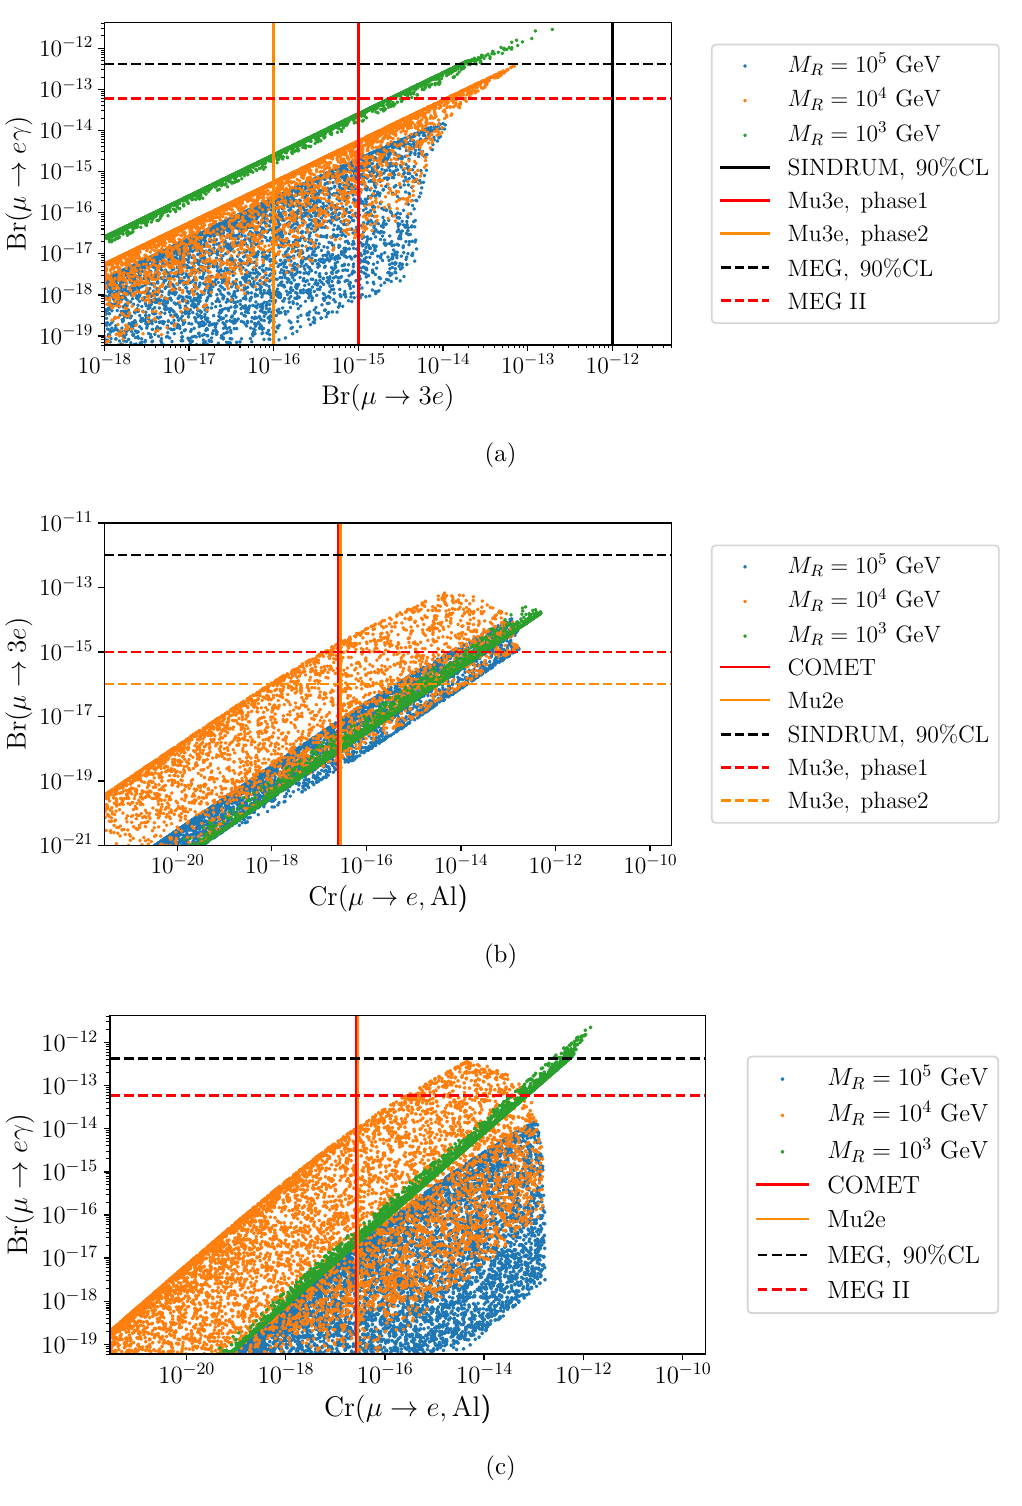
Figure 12. Correlations between the processes µ → 3 e , µ → eγ and µ → e conversion in aluminium nuclei. The current experimental upper limits are indicated by the black lines while the future sensitivities are shown in red and